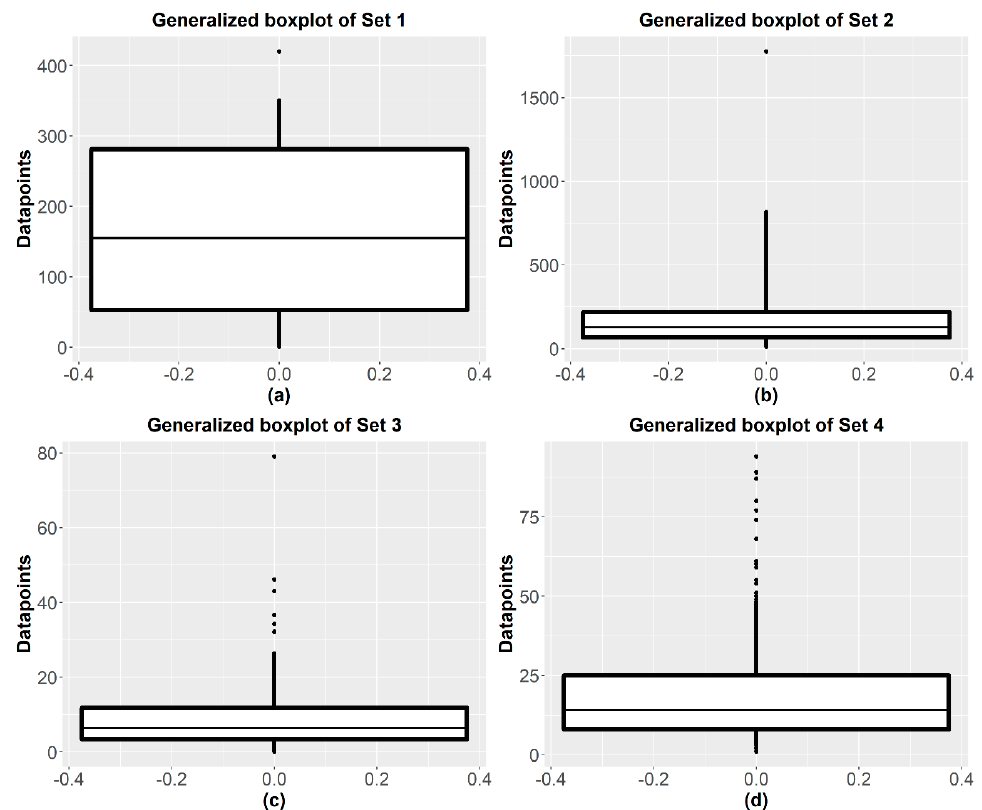
Figure 2. Generalized boxplot for data ( a ) Set 1, ( b ) Set 2, ( c ) Set 3 and ( d ) Set (4).